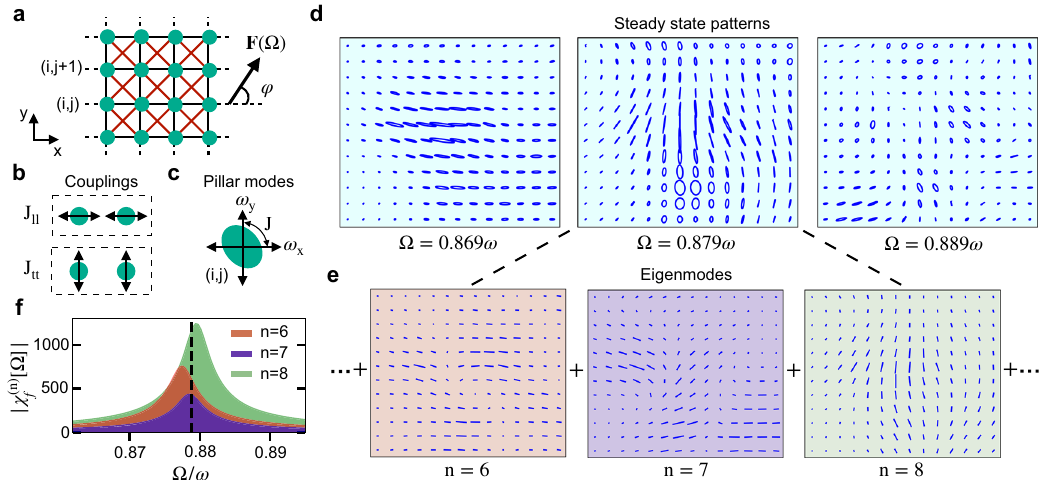
Fig. 3 Tight-binding model for coupled pillar dynamics. a Schematics of a pillar array with the nearest (black) and the next-to-nearest (red) neighbor couplings. b Sketch of the two types of couplings between the neighboring pillars. c Modeling an isolated pillar as two coupled harmonic oscillators with frequencies ω x , y and coupling J . d Steady-state motion in a section of the array for various driving frequencies Ω renormalised with mean pillar frequency ω . Each pattern is composed of a linear superposition of all the eigenmodes with their appropriate susceptibility j χ ð n Þ f ½ Ω (cid:5)j . e Three highest contributing eigenmodes for the steady-state pattern at Ω = 0.879 ω . Notice that the eigenmodes contain only linear motion, thus the steady-state pillar trajectory can be elliptical only if more than one eigenmode contributes to it. f Contribution of each eigenmode in e to the steady-state pattern as a function of Ω . The dashed line indicates Ω = 0.879 ω . Parameter values of the tight-binding model are given in Supplementary Table